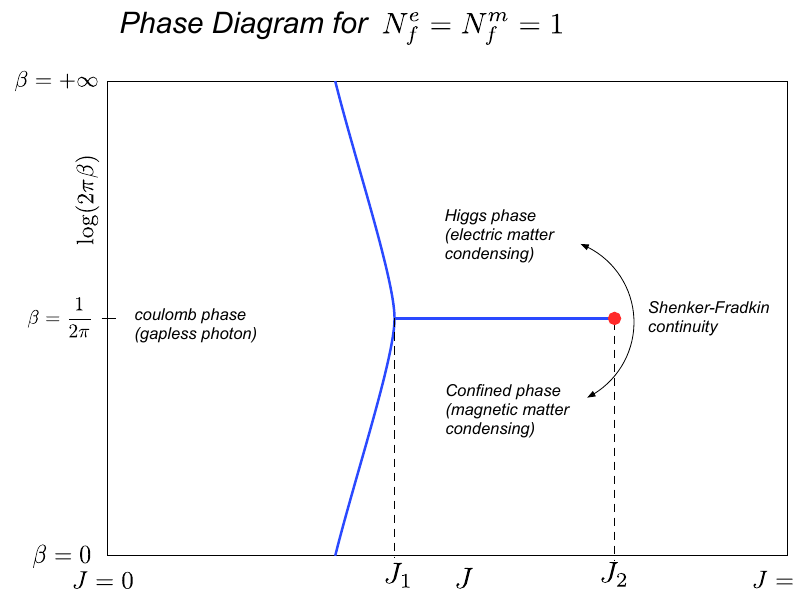
Figure 2 . A cartoon of the phase diagram in the J , log(2 πβ )